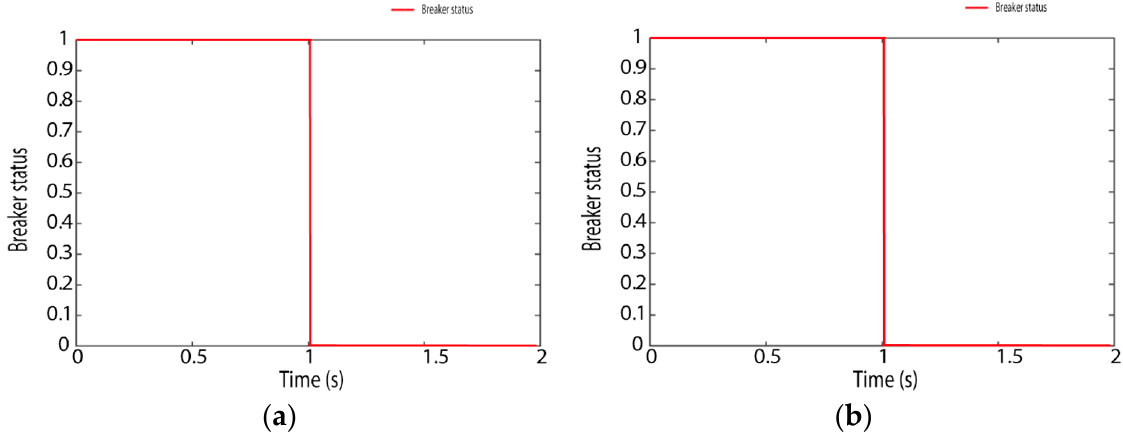
Figure 15. Trip signal for ( a ) CB5 and ( b ) CB6 during three-phase fault.